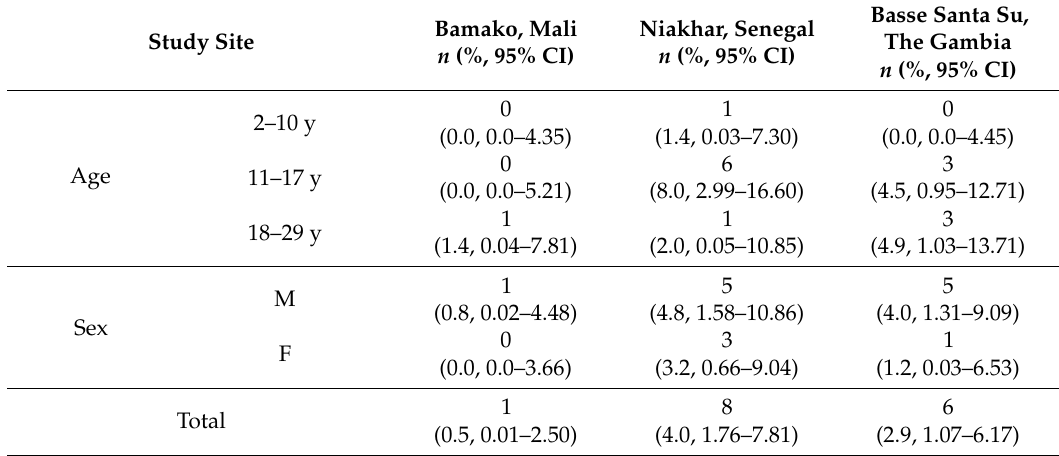
Table 3 . Anti-ZIKV MNT seroconversions in samples collected in Mali, Senegal and The Gambia, by age group and sex ( n , %, 95%CI).